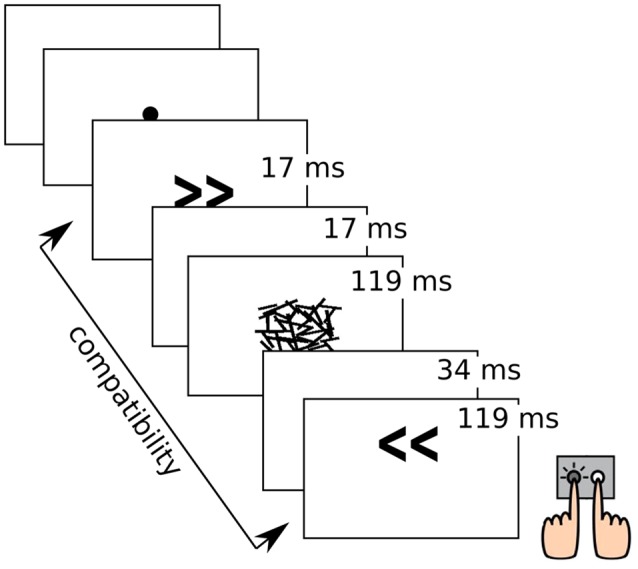
Illustration of the experimental task with stimulus durations. Object sizes are not true to scale.